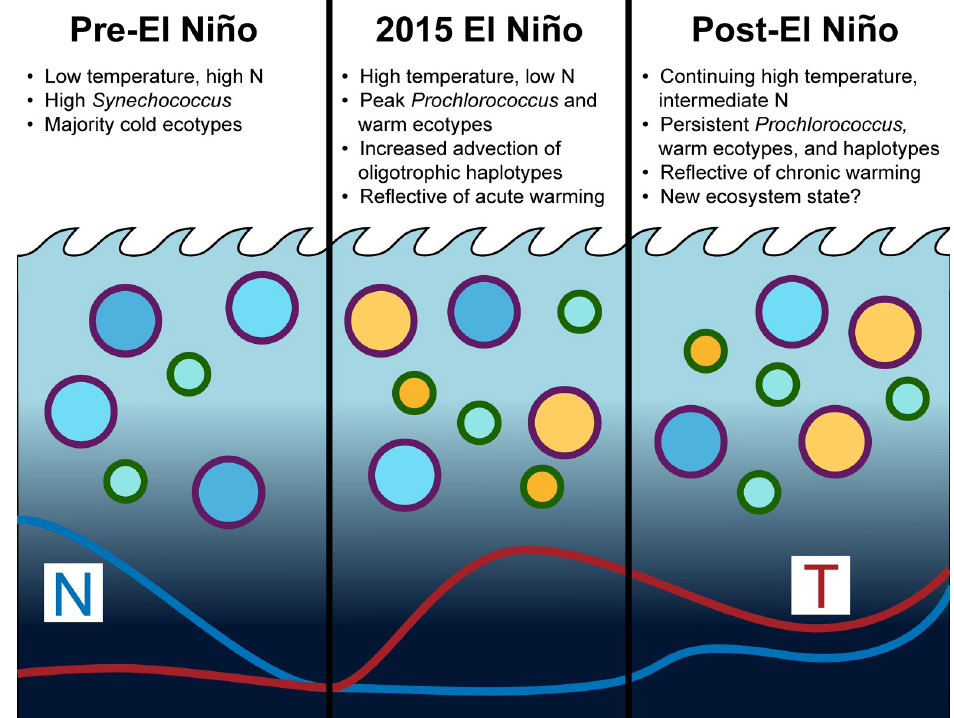
Fig 6. Conceptual diagram of picocyanobacterial community shifts at the MICRO time series from 2009–2018. Synechococcus cells are outlined in purple and Prochlorococcus cells are outlined in green. Blue cell shading indicates cold temperature-adapted ecotypes and yellow cell shading indicates warm temperature-adapted ecotypes. The blue line indicates the nitrate trend (N) and the red line indicates the temperature trend